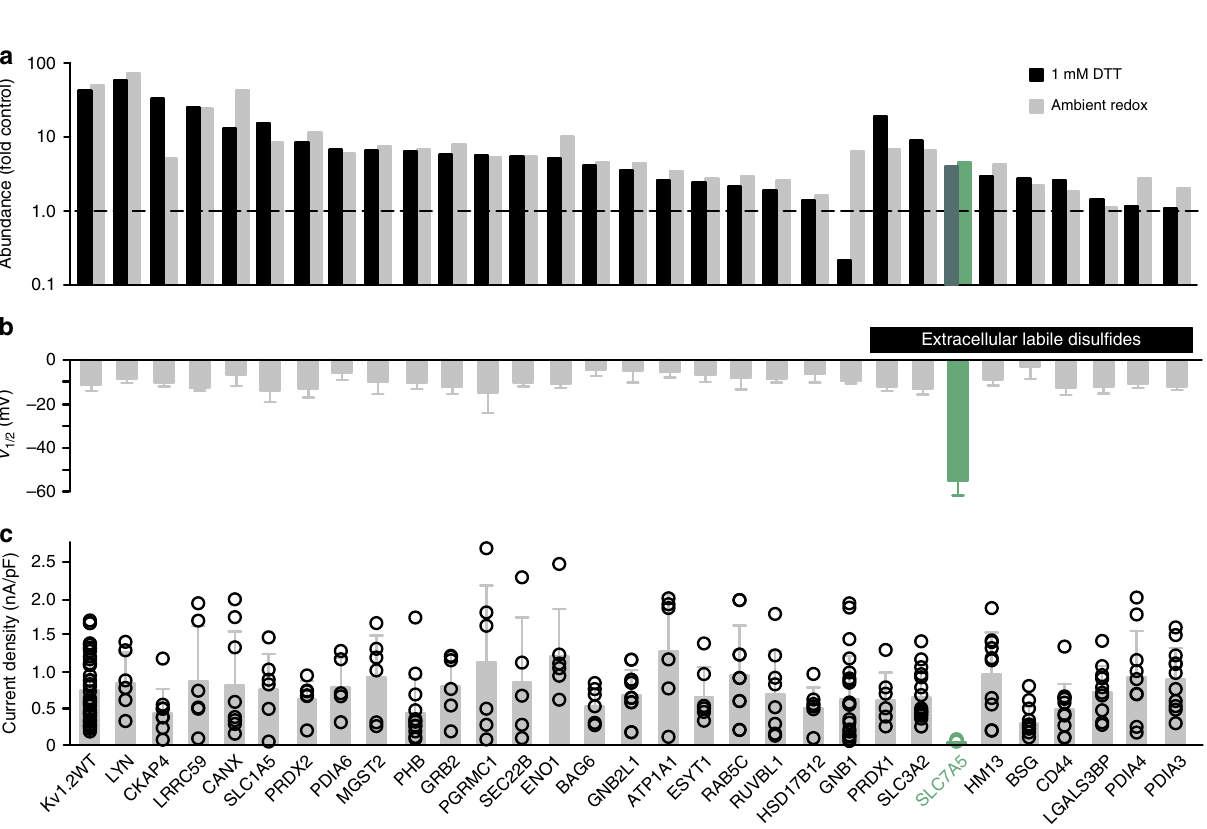
Fig. 1 Mass spectrometry and screening of Kv1.2 channel complexes. Kv1.2-1D4 was expressed in HEK cells, and EGS-cross-linked complexes were immunoprecipitated and analyzed by LC – MS/MS. Thirty proteins were chosen for further screening. a Abundance of proteins relative to untransfected cells, with cross-linking performed in ambient redox conditions (gray) or 1 mM DTT (black). Proteins containing labile extracellular disul fi des are indicated by the black bar. b V 1/2 (mean ± s.d.) was determined for Kv1.2 when co-expressed with each candidate gene (mEGFP-tagged) in ltk -mouse fi broblasts. Conductance-voltage relationships were measured by stepping between − 120 and + 60 mV (100 ms in 10 mV steps, − 80 mV holding potential) followed by a tail current voltage of − 30 mV. In addition, a 100 ms depolarization to + 60 mV was delivered before each sweep to relieve use-dependent activation ( n = 5 – 15, n = 31 for WT Kv1.2). c Kv1.2 current densities at + 60 mV (pulsed from a holding potential of − 80 mV) after co-expression with each candidate gene. The data from individual cells are superimposed on bars that represent mean ± s.d. ( n = 5 – 15, n = 31 for WT